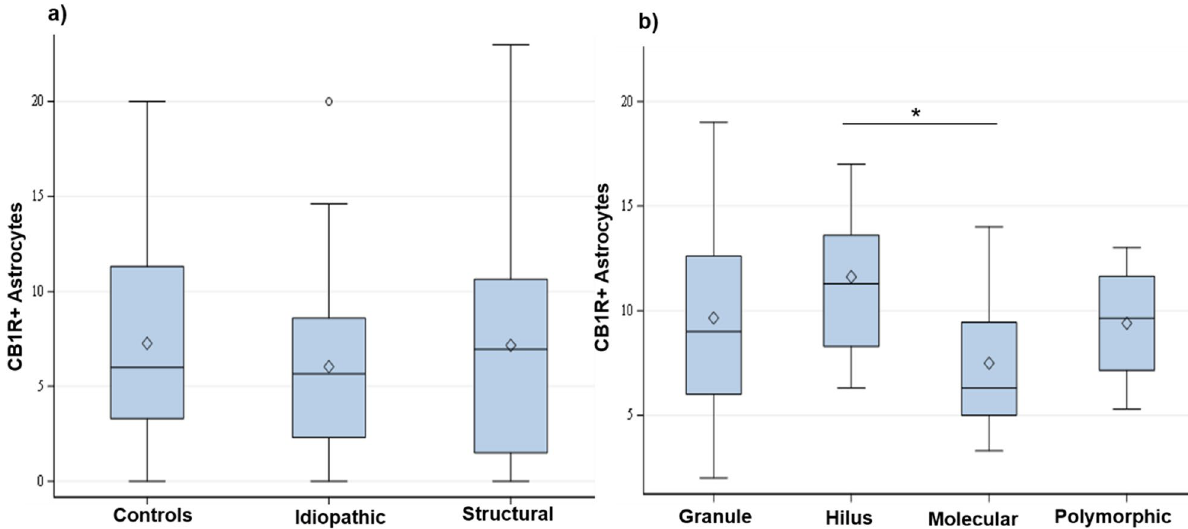
Figure 5. CB1R positive astrocytes quantification. ( a ) Number of CB1R positive astrocytes in different groups and ( b ) different layers calculated for the control group. The cell numbers are expressed per visual field. Boxes represent values from the first to third quartile of CB1R positive astrocytes, inside horizontal lines indicate median values, ◊ represents mean values and vertical lines represent maximum and minimum values; outliers are marked with ○ . Asterisk (*) indicate a statistically significant difference ( p = 0.0044) between the number of CB1R positive astrocytes in the hilus and molecular layer of the dentate gyrus in tissue from control animals. CB1R + : cannabinoid receptor type 1 positive; controls: tissue of control dogs; Idiopathic: tissue of dogs with idiopathic epilepsy; Structural: tissue of dogs with structural epilepsy; Granular: granule cell layer; Molecular: molecular layer; Polymorphic: polymorphic